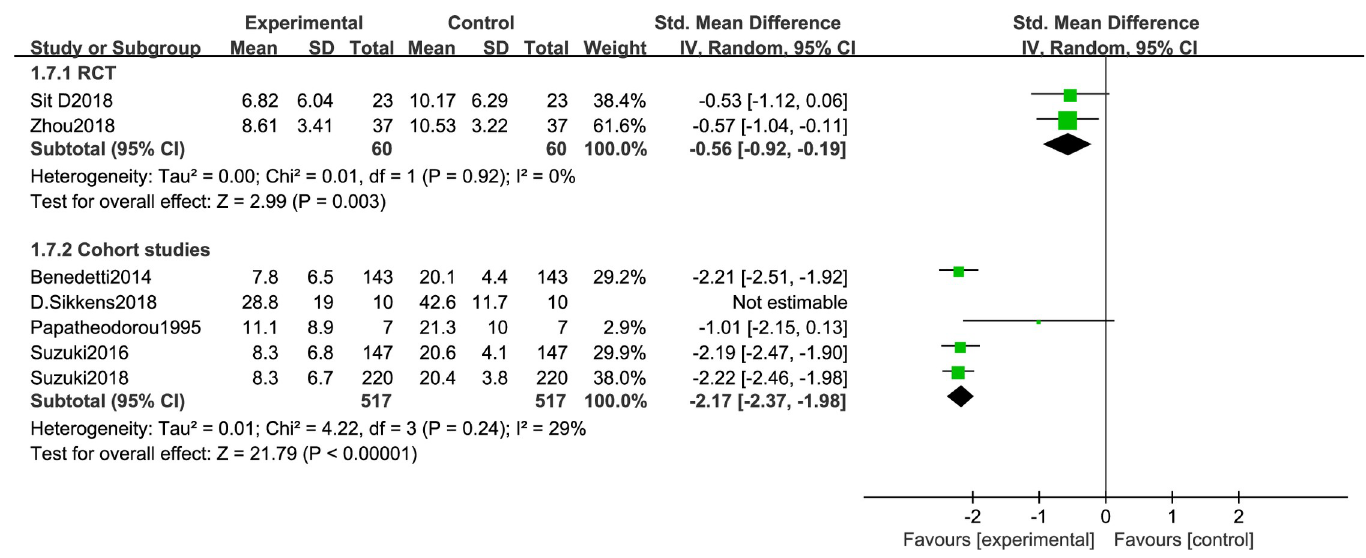
Fig 7. Forest plots for white light